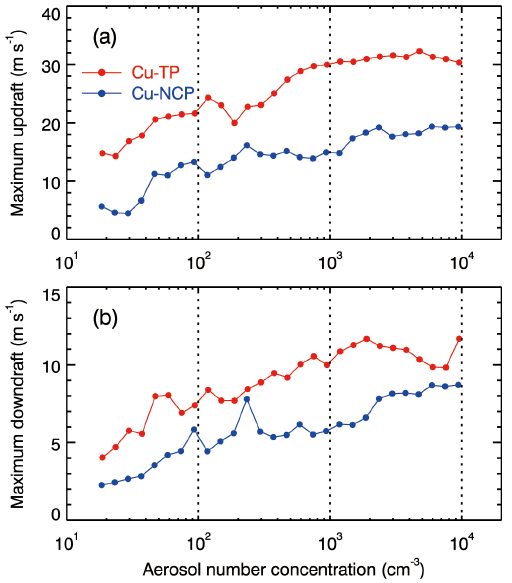
Figure 6. Modeled (a) maximum updraft and (b) minimum down- draft as a function of the initial [ N a ] in Cu-TP and Cu-NCP.